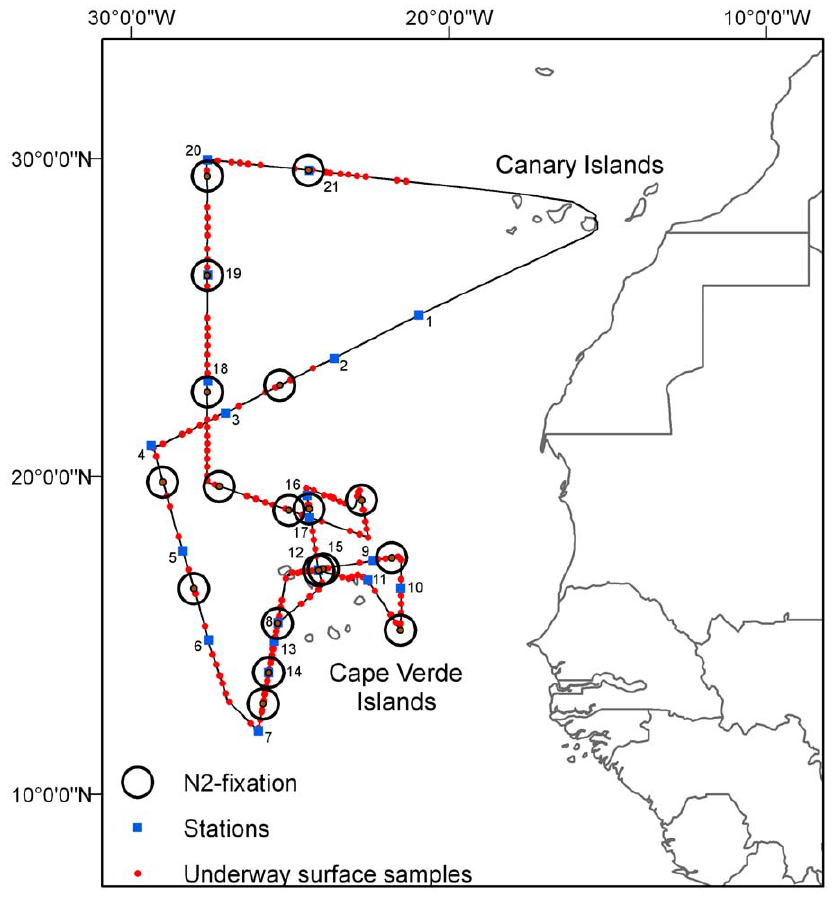
Figure 1. The cruise track of the P332 cruise in January-February 2006.